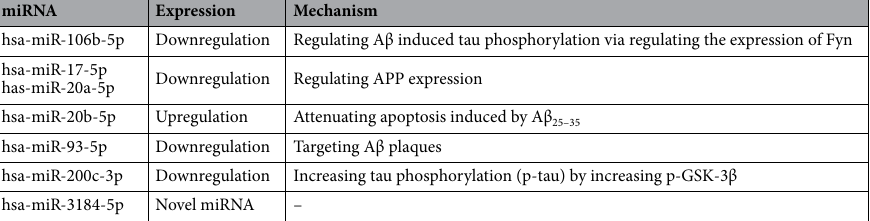
Table 3. miRNAs interpretation. This table describes the mechanisms of 7 significant miRNAs in the cross- talk between DM and AD. Only miR-3184-5p introduced in this study as a novel miRNA in this cross-talk which needs additional experimental research.